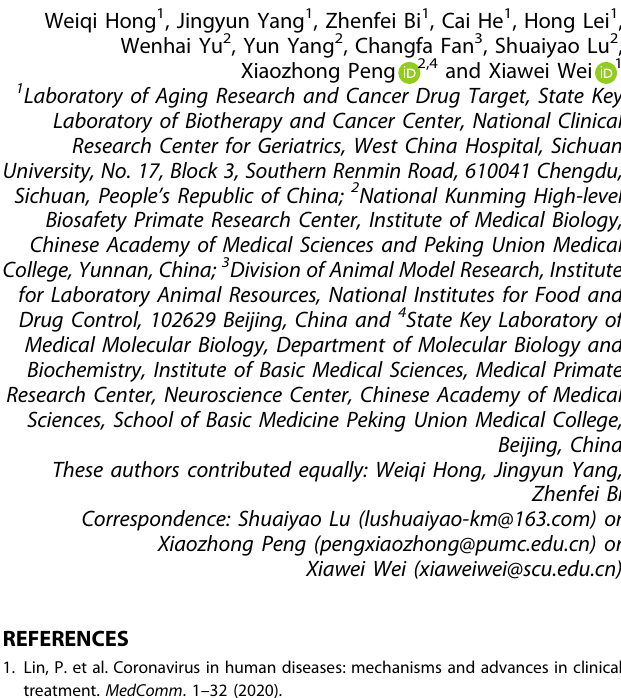
Fig. 1 The characterization and treatment of a mouse model for SARS-CoV-2-induced acute respiratory distress syndrome (ARDS). a The establishment of a mouse model of ARDS. Illustration for routine tracheotomy and intratracheal instillation of SARS-CoV-2 in mouse (4 × 10 5 PFU). b Morphology of the lung from the mouse 5 days after intratracheal instillation of SARS-CoV-2 (4 × 10 5 PFU). c , d The pulmonary pathological changes in mice after intratracheal instillation of SARS-CoV-2 characterized by H&E staining. e TUNEL labeling was used to detect the cell apoptosis in lung tissue as described in Supplementary Materials. f The neutrophils were predominant cell in fi ltration with 60% of lung tissues consolidated as stained by H&E staining. g The neutrophils were stained positive for Ly6G. h Apparent hemorrhage, with the red blood cells fi lling the alveolar spaces in the section. i In fl ammatory cells, red blood cells, and proteinaceous debris were found in the bronchioles. j Proteinaceous and cellular debris were found in the alveolar space (arrow). k Hyaline membranes-like changes lining alveolar cavities (arrow). l The thrombi were present in the vessels (arrow). m The immunostaining of SARS-CoV-2 spike protein in the lung section of a mouse with SARS-CoV-2-induced ARDS, as described in Supplementary Materials. n Pathological scores for mice from SARS-CoV-2-induced ARDS group or dexamethasone-treated group according to the scoring system ( n = 3 mice). o The lung weights of mice from SARS-CoV-2- induced ARDS group or dexamethasone-treated group ( n = 3). Mice were treated with dexamethasone as described in Supplementary Materials. p Cytokines changes in mice from SARS-CoV-2-induced ARDS group or dexamethasone-treated group ( n = 3). Cytokines were measured as described in Supplementary Materials. Scale bars represent 2000 μ m ( c ) or 20 μ m ( d – m ). Statistical analysis of pathological score ( n ) and lung weight ( o ) was analyzed by Student ’ s unpaired t test, and cytokines changes ( p ) data were analyzed by one-way ANOVA. All error bars represent SEM about the mean. ** P <